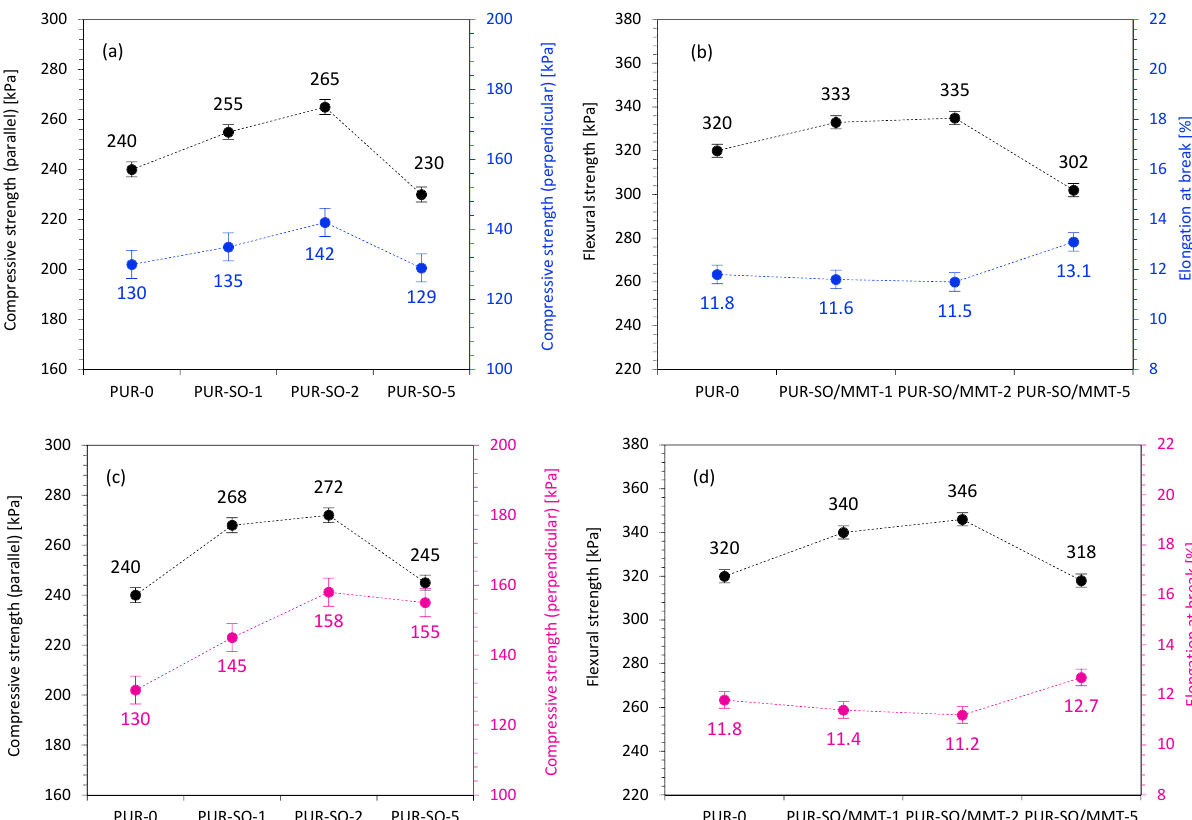
Figure 11. Mechanical performances of PUR composites reinforced with ( a , b ) unmodified SO filler and ( c , d ) MMT-modified SO filler.